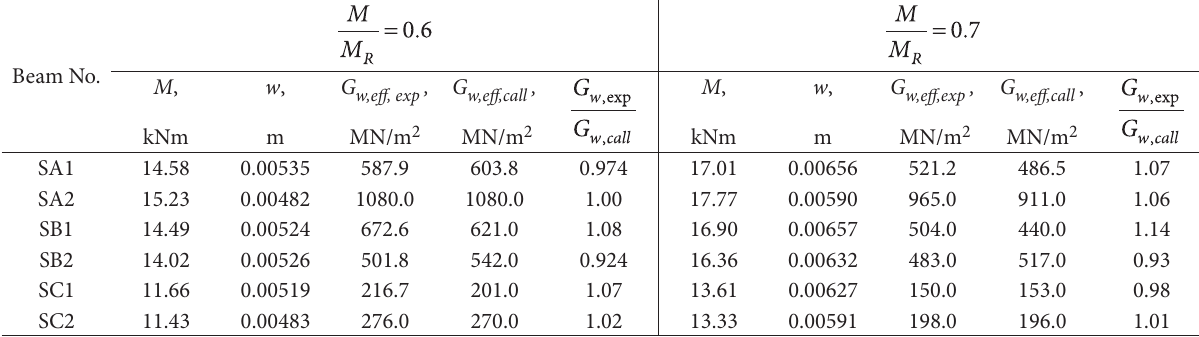
Table 1. The experimental and the theoretical equivalent effective shear modulus of the steel and concrete connection